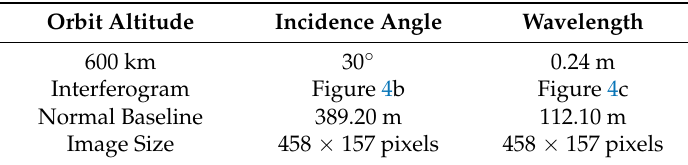
Table 1. Major parameters of the simulated InSAR